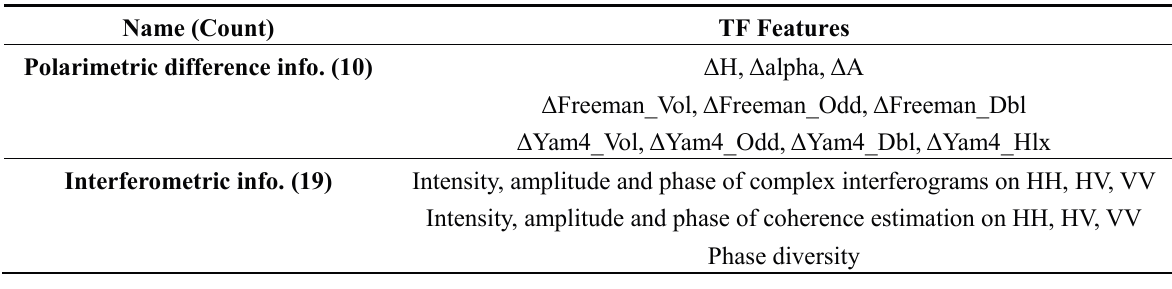
Table 3. Features obtained by sub-aperture